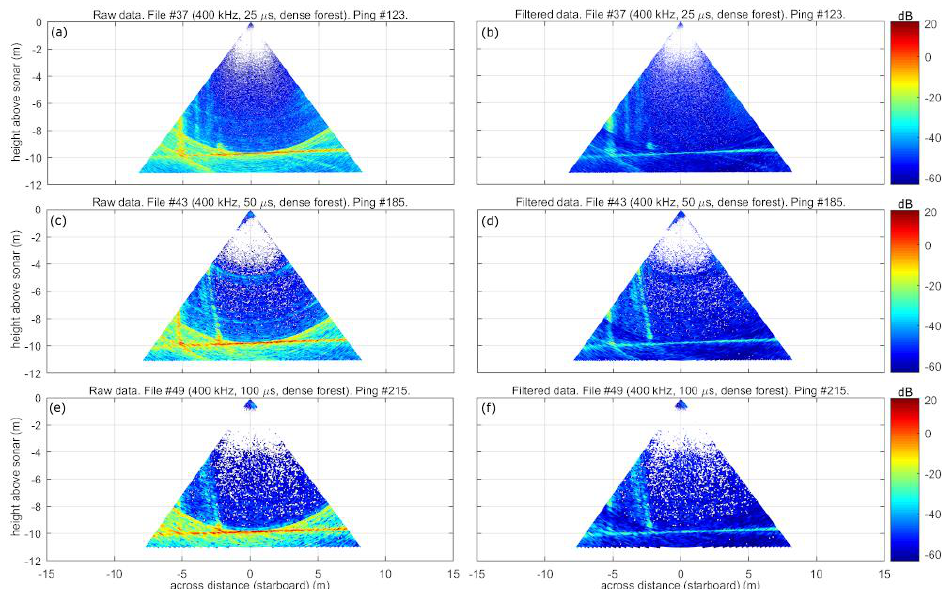
Figure 7. Illustration of EM 2040 C MBES water-column data acquired at 400 kHz over the dense forest patch before and after application of the SRSN filter, for different pulse length settings: ( a ) 25 µ s pulse data example before filtering and ( b ) same ping after filtering, ( c ) 50 µ s pulse data example before filtering and ( d ) same ping after filtering, ( e ) 100 µ s pulse data example before filtering and ( f ) same ping after filtering. Data shown are for the ping corresponding to the shortest horizontal distance to the patch, in the first file acquired for each setting.